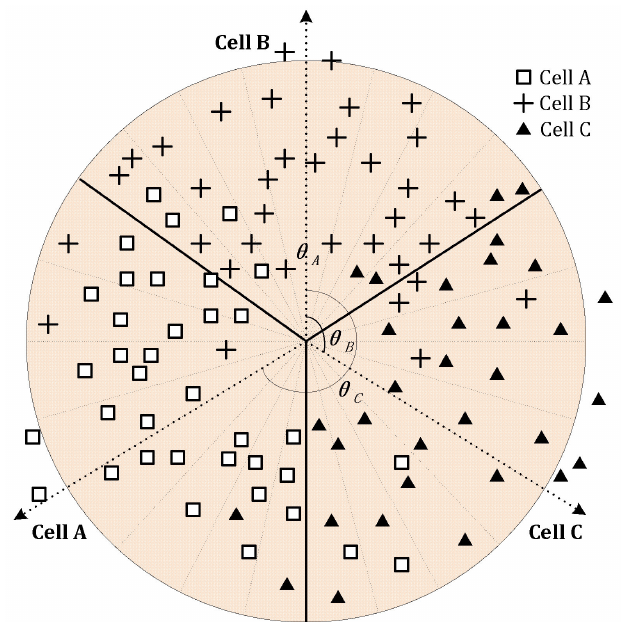
Figure 5. Estimation of azimuth with chordwise